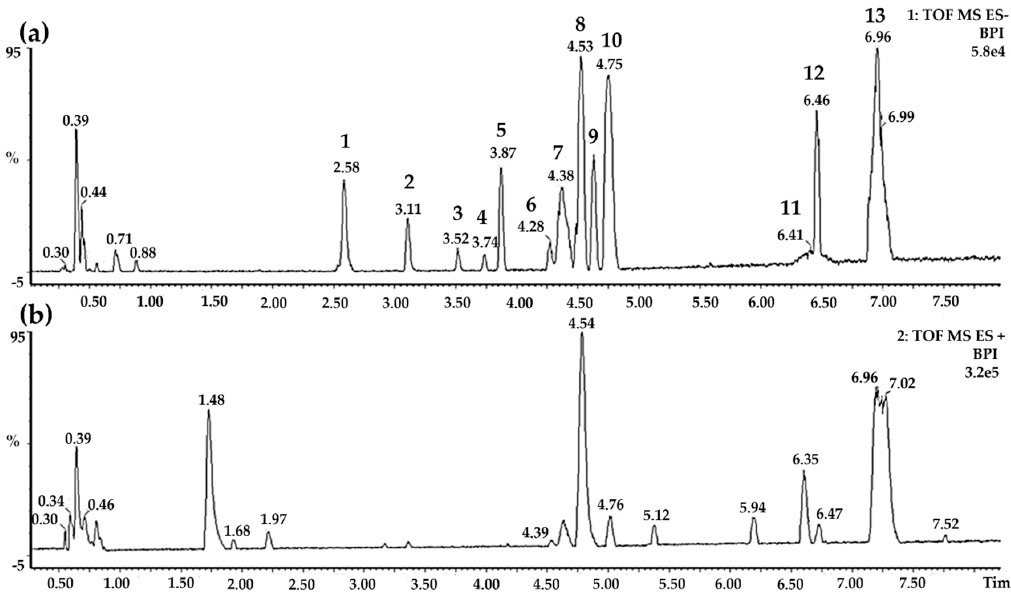
Figure 1. Chemical composition of Mansoa hirsuta fraction (MHF). ( a ) Electrospray ionization (ESI) base peak ion (BPI) chromatogram of the M. hirsuta fraction analyzed by ultra-high performance liquid chromatography-quadrupole time-of-flight mass spectrometry (UPLC-QTOF-MS-ES-); ( b ) ESI base peak ion (BPI) chromatogram of the M. hirsuta fraction analyzed by UPLC-QTOF-MS-ES+.